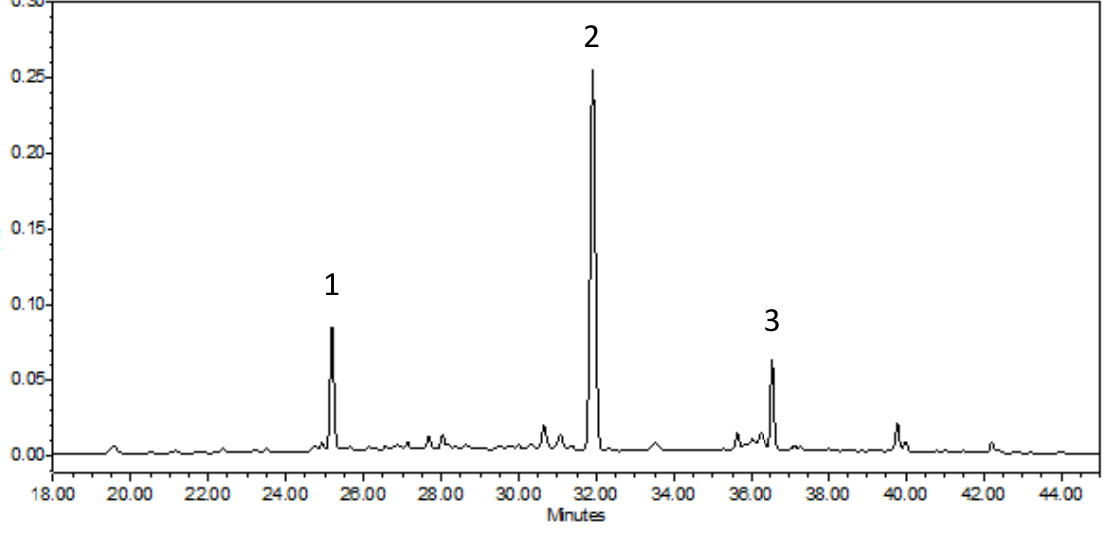
tin-hexoside; (8) methylmirecitin derivative 2, (9) methoxynaringenin derivative, (10) querce-